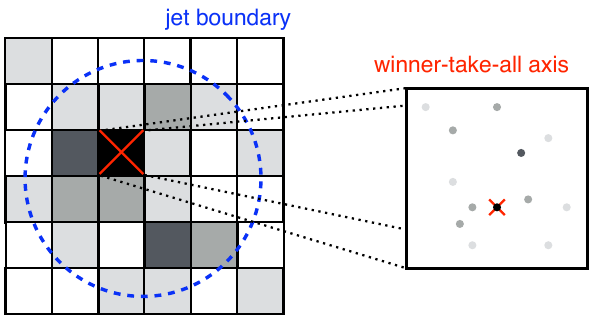
Figure 2 . Factorization of the axis (cid:12)nding between the angular scale r = j k j =p T and R , with r (cid:28) R